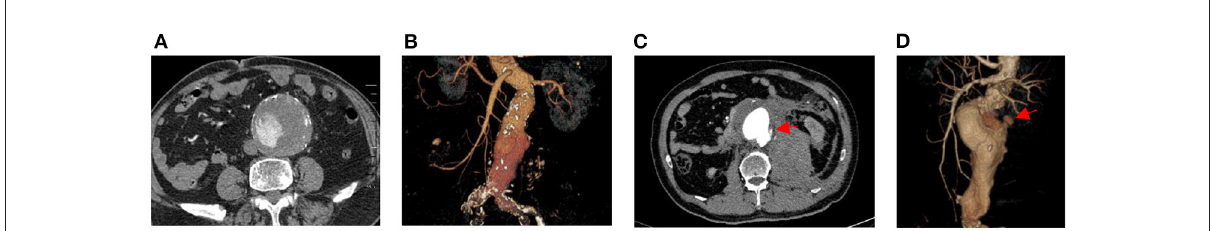
FIGURE1 Flow chart of the patient selection.